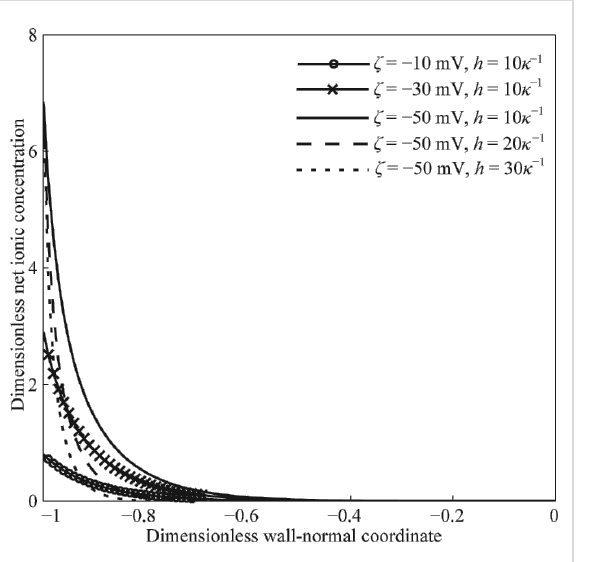
Figure 4: The effect of zeta potential on the average electrical conduc- tivity in the non-overlapping EDL. Effect of EDL on flow field The velocity field After obtaining the electrical potential and ionic concentration in the non-overlapping EDL and the change in the average elec- trical conductivity and the slip length caused by the surface charge, the velocity field of the pressure-driven flow in the one- dimensional parallel-plates microchannel can be analyzed using Equation 12. Figure 5 shows examples of the dimensionless velocity field in the microchannel with different conditions at the channel walls. Using the velocity field in the case of no slip and no surface charge (the blue solid line) as a reference, the existence of surface charge reduces velocity of the fluid